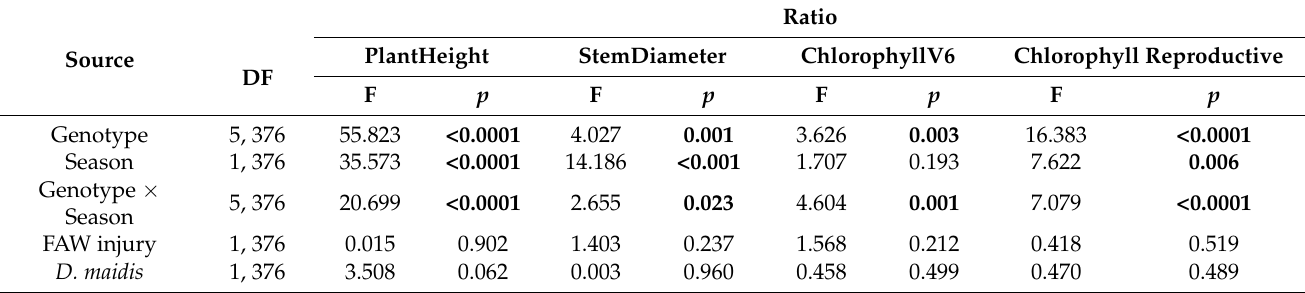
Table 2. Analysis of covariance (ANOVA) statistics for the independent variables genotype (Amarel ã o, Aztequinha, Branco Antigo, Palha Roxa, S ã o Pedro, and BM207), season (1 and 2), and genotype × season interaction for the tolerance ratio plant height, stem diameter, and chlorophyll content at vegetative stage V6 and reproductive stage. The FAW injury and D. maidis was added to the model as